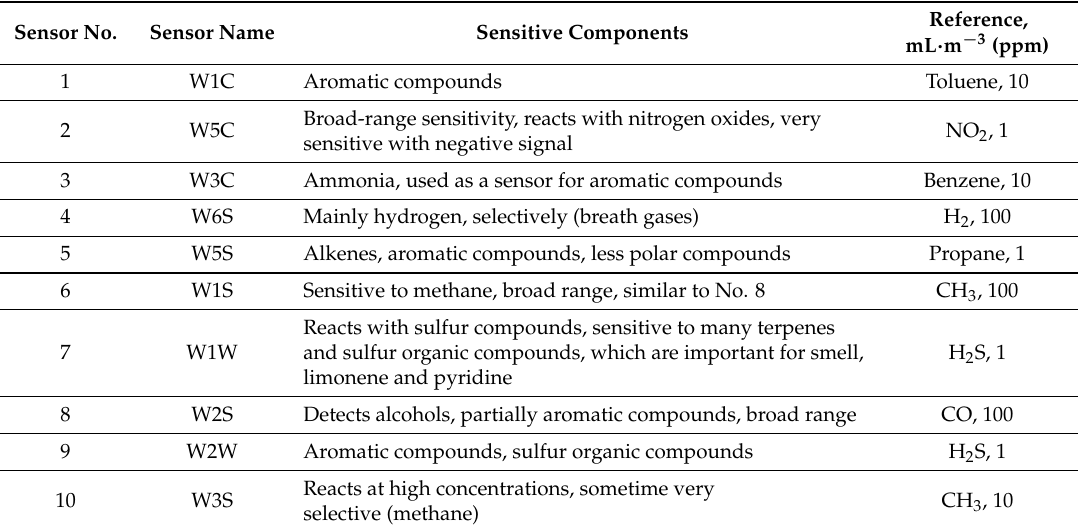
Table 1. Sensors used in this study and their main application in PEN3. Sensor